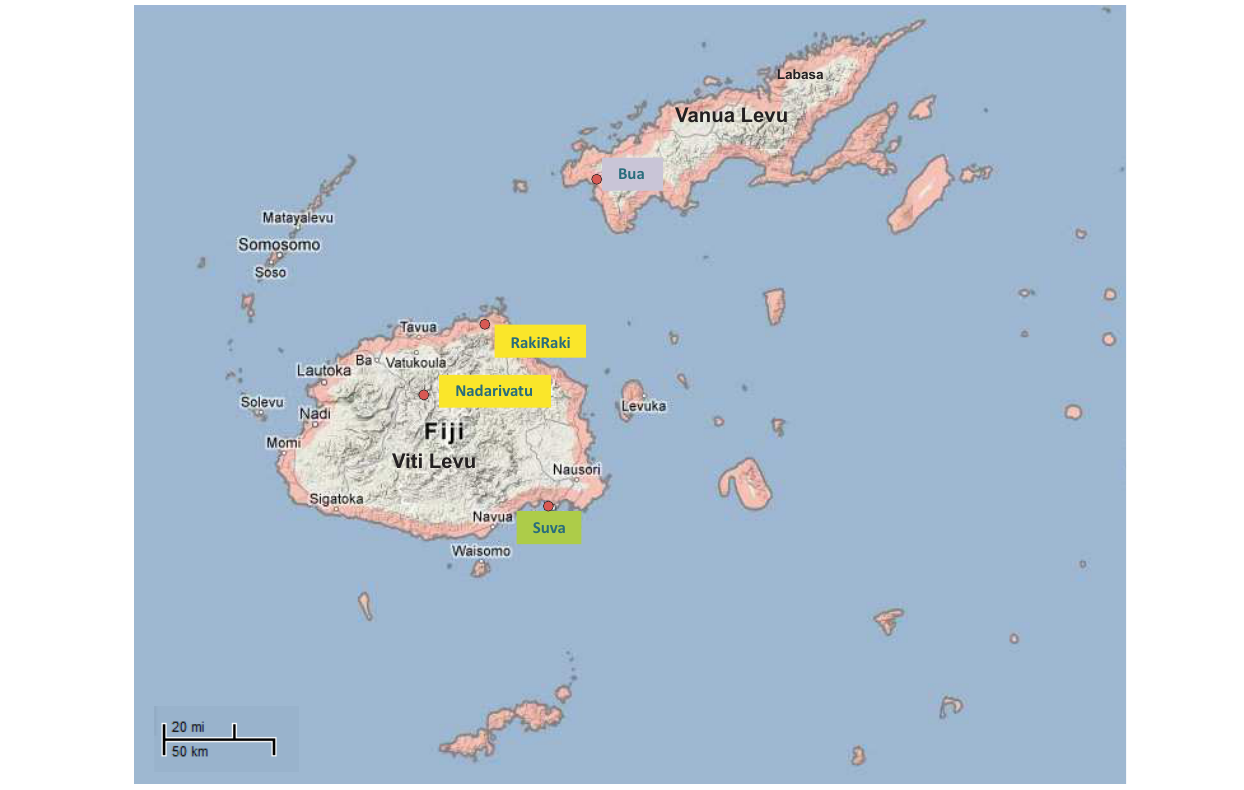
FIGURE 1 | Map of Fiji islands showing the sampling locations. A total of 179 samples were collected from four rural Melanesian Fijian villages in two Western regions of the main island of Fiji (Viti Levu):Nadarivatu (villages of Naga and Koro) and Rakiraki (Nasavu and Nauria) highlighted in yellow, from